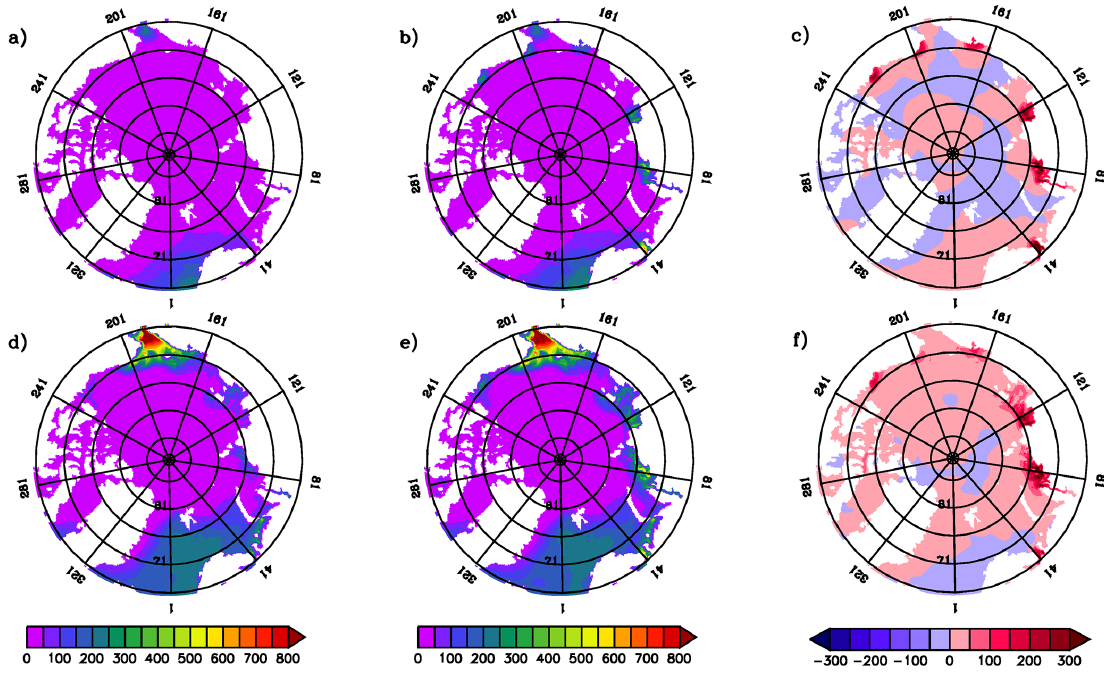
Figure 4. Seasonal climatology of the 0–50m integrated bacterial biomass (mmolNm − 2 ) for spring (upper panels) and summer (lower panels) over the 1998–2011 period simulated in the CTRL run (left panels a and d ) and in the RIV run (middle panels b and e ). Right panels ( c and f ) provide the absolute difference (gCm − 2 ; RIV run – CTRL run).